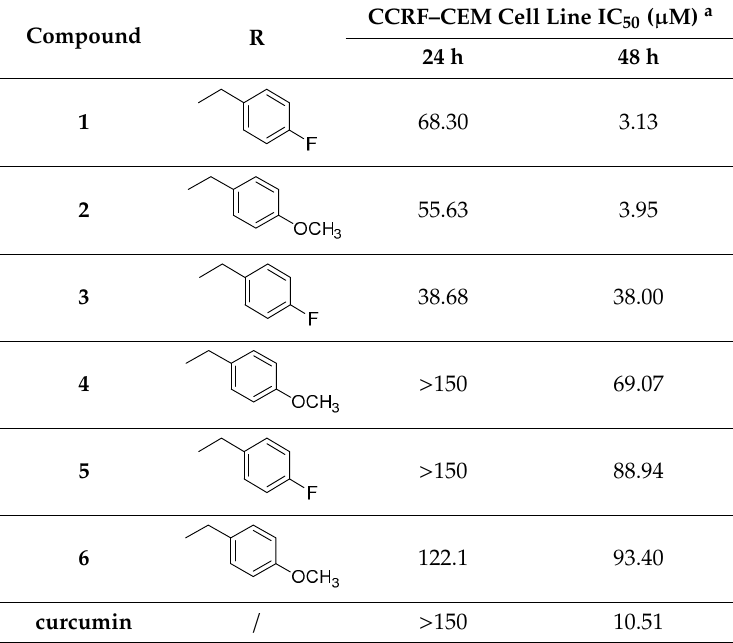
Table 1. Cytotoxic effect of compounds 1 – 6 against T acute lymphoblastic leukemia cell line (CCRF–CEM).